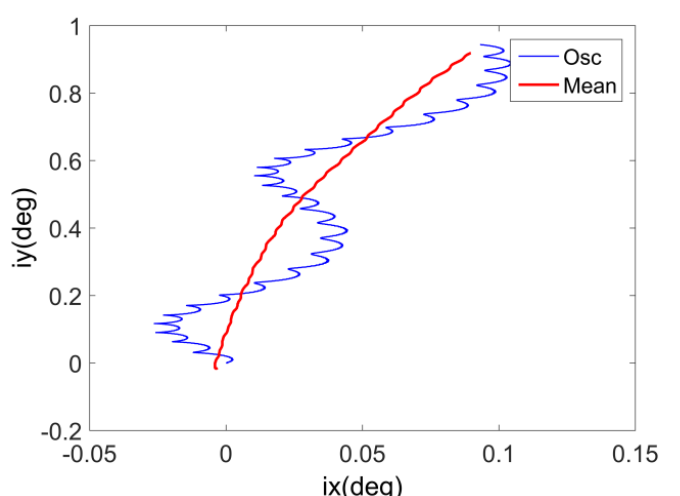
Figure 1. Mean orbital inclination vector under the influence of the nutation period term.